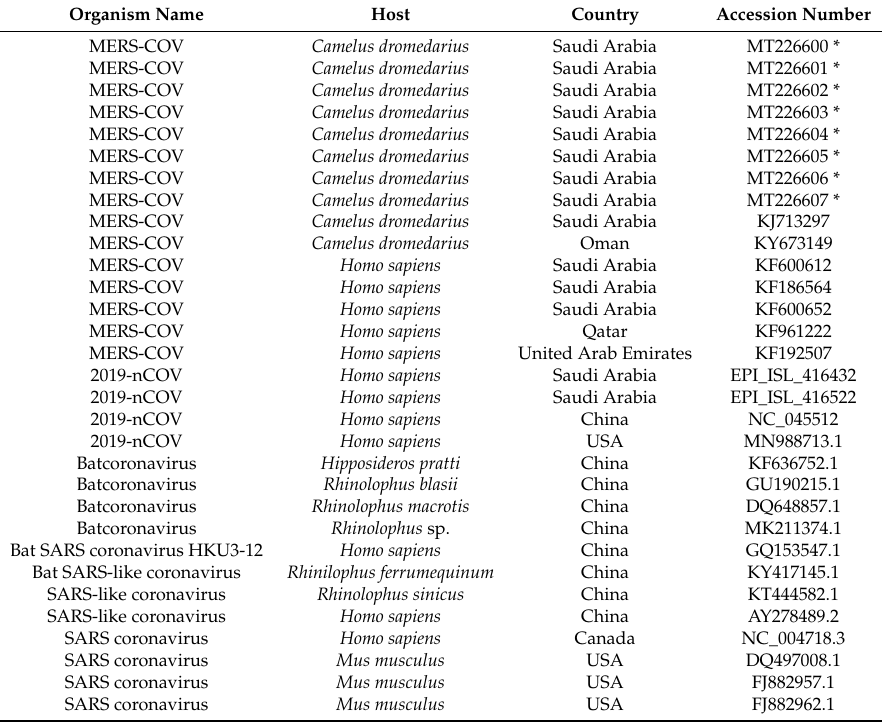
Figure 4. Geographical distribution of dromedaries in Saudi Arabia infected with MERS-CoV viruses that were isolated in the present study. The number of dromedaries corresponds to the number of isolates from the sampling location. Table 3. List of viruses from genus Betacoronavirus with sequences used in this